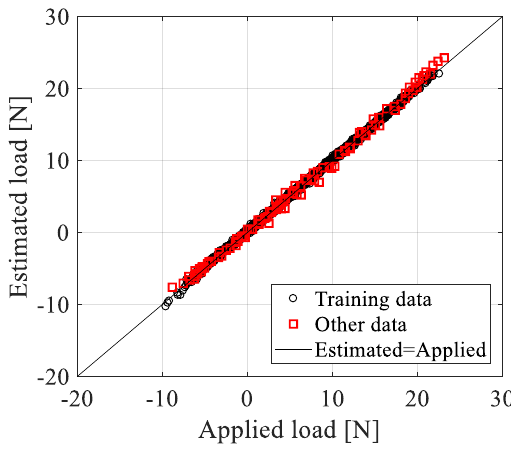
Figure 11. Comparison between applied and estimated loads.